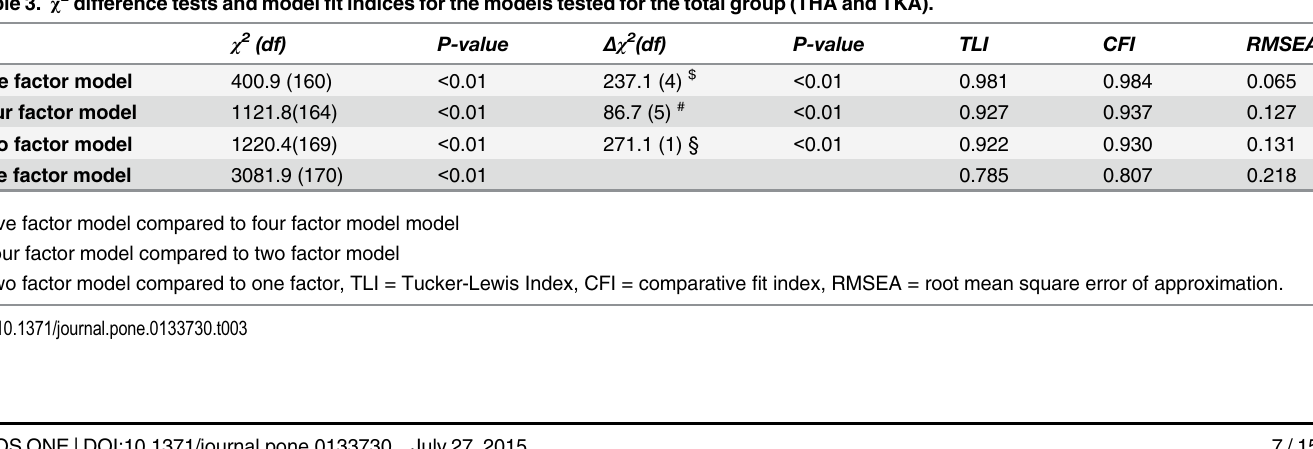
* The THA patients completed the HOOS questionnaire and the TKA patients completed the KOOS questionnaire. HOOS = the Hip injury and Osteoarthris Outcome Score, KOOS = the Knee injury and Osteoarthritis Outcome Score, CEQ = Credibility Expectancy Questionnaire, HS = Hope Scale, LOT-R = Life Orientation Test Revised.